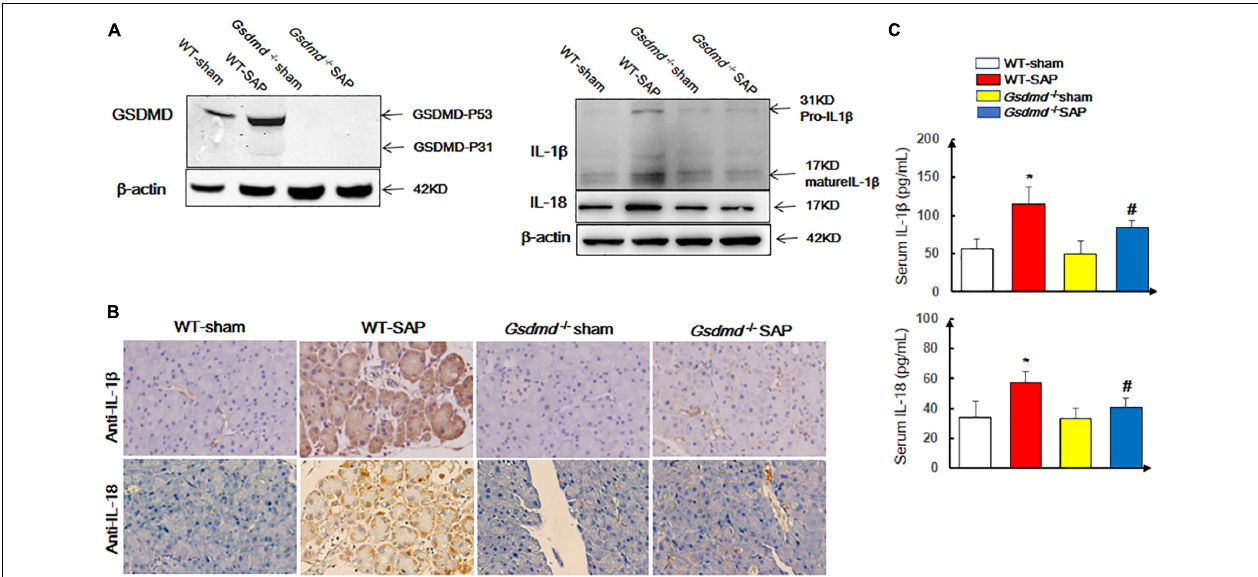
FIGURE 1 | GSDMD-mediated pyroptosis is activated in pancreatic tissues in severe acute pancreatitis mouse models. Mice were sacrificed 24 h after LPS injection, and samples were collected. (A,B) The pyroptosis-associated molecules GSDMD, IL-1 β , and IL-18 were analyzed by Western blotting and IHC. Scale bar, × 200. (C) Serum IL-1 β and IL-18 levels were detected by ELISA. *p < 0.05 vs. other groups; # p < 0.05 vs. Gsdmd − / − sham group. Experiments were repeated three times. Data are expressed as mean ± SD, n = 10 per WT group, n = 8 per Gsdmd − / − group. GSDMD, gasdermin D; LPS, lipopolysaccharide; IHC, immunohistochemistry; WT, wild